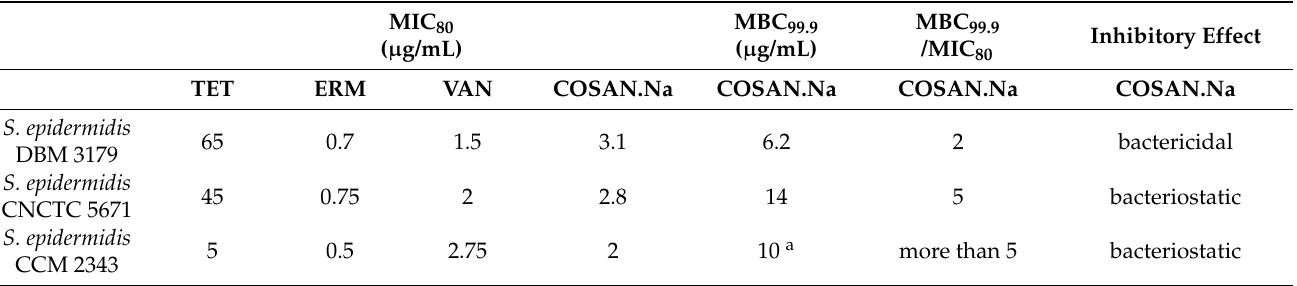
Table 1. Effect of antibiotics or sodium salt of cobalt bis-dicarbollide (COSAN.Na) on plank- tonic growth of S. epidermidis